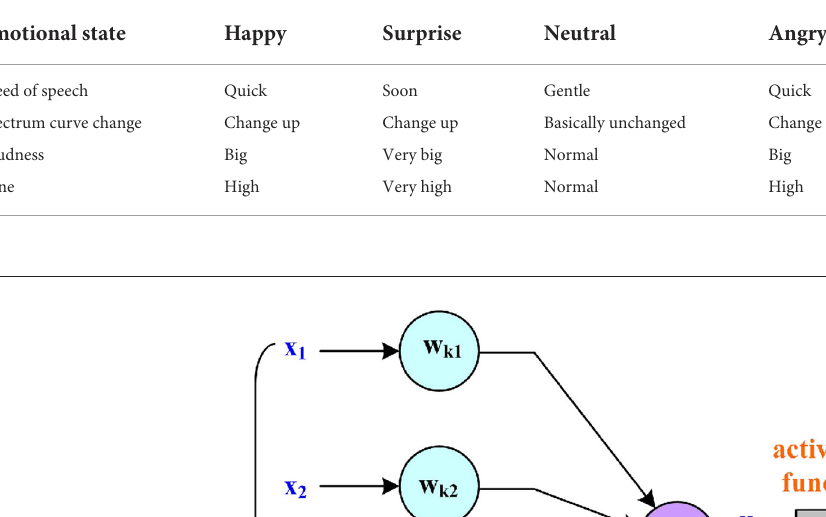
TABLE 1 Relationship between emotional state and speech feature parameters.